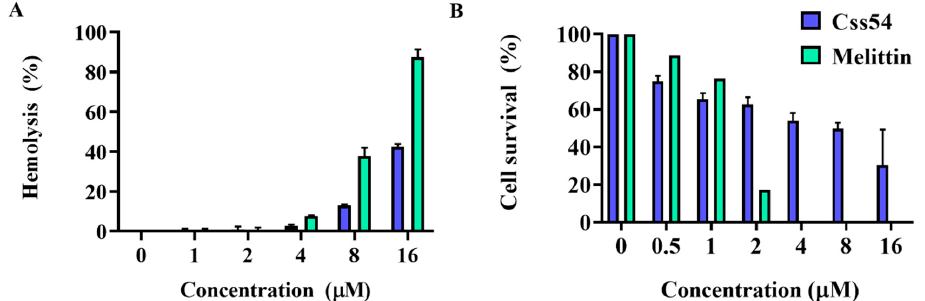
Figure 3. Hemolysis and cytotoxicity of antimicrobial peptides (AMPs). ( A ) Hemolytic activities were determined by measuring the release of hemoglobin from sRBCs at an absorbance wavelength of 414 nm. Percentage of hemolysis in sheep RBCs incubated with peptides at increased concentrations. ( B ) Cytotoxicity assay of AMPs. PK(15) cells isolated from porcine kidney were treated with Css54, and melittin at different concentrations in DMEM supplemented 10% FBS. Cell survival rates were measured by MTT assay.